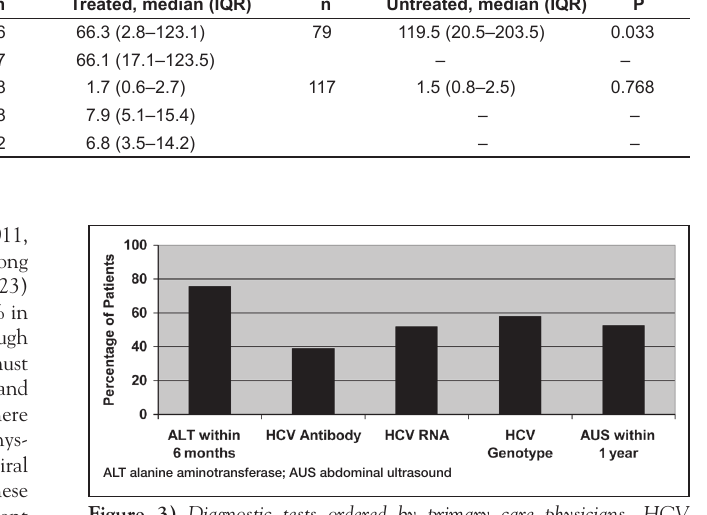
Figure 3) Diagnostic tests ordered by primary care physicians. HCV